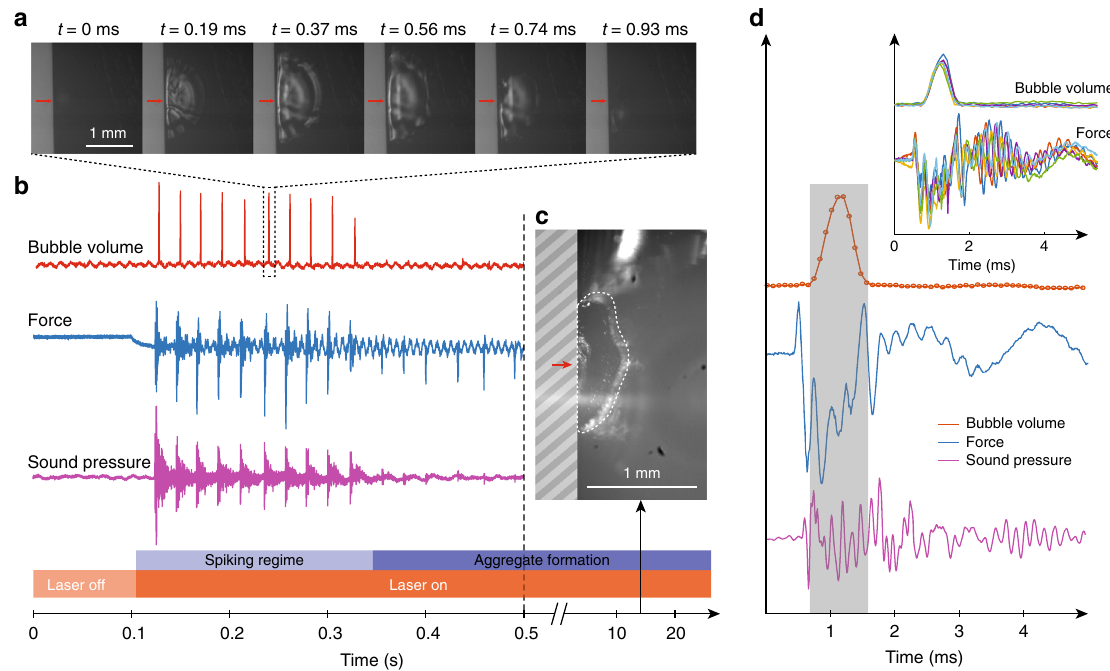
Fig. 3 Microscopic investigation of the origin of the photomechanical effect. The four panels show results of simultaneous measurement of force and sound pressure, coupled to ultrafast imaging (11,000 fps), in a 1 mm-thick spectroscopic cuvette. a High-speed photography snapshots of the dynamics of a bubble growing and collapsing upon laser illumination. The red arrow indicates the laser impact point. b Typical recording of force and sound vs. time and of the volume of the bubble in solution as determined by optical imaging. c Image of the particle aggregate that becomes visible after about 10 s illumination. The red arrow shows the impact point of the laser, the grey striped rectangle emphasises the cuvette wall and the dashed white line highlights the aggregate in the image. d Bubble volume, force and sound pressure vs. time, averaged over the fi rst six spikes shown in b . The grey rectangle is a guide to the eye highlighting that the onset of the force spike precedes bubble growth. Inset: aligned time traces of six force spikes, showing very reproducible synchronisation with the bubble